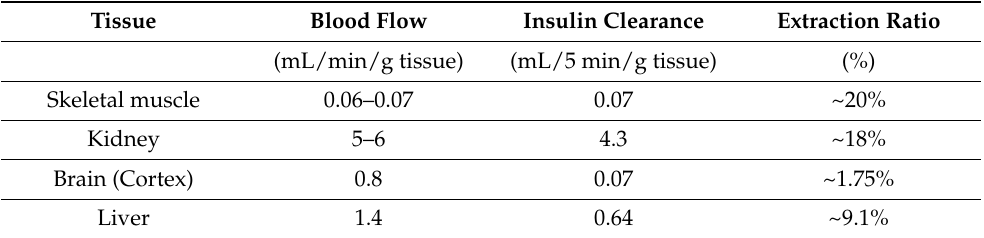
Table 1. Tissue-specific blood flow, insulin clearance, and extraction ratio from rats studied under protocol 1 not treated with S961. Data for brain blood flow, clearance, and extraction ratio (ER) are provide for comparison. Tissue Blood Flow Insulin Clearance Extraction